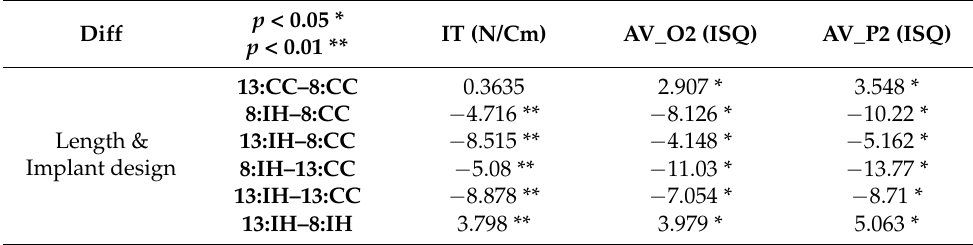
Table 4. The difference of average implant stability measurements between the combined tested parameters of CC or IH implant design and implant length as measured by IT, Osstell (O2) and Penguin (P2)